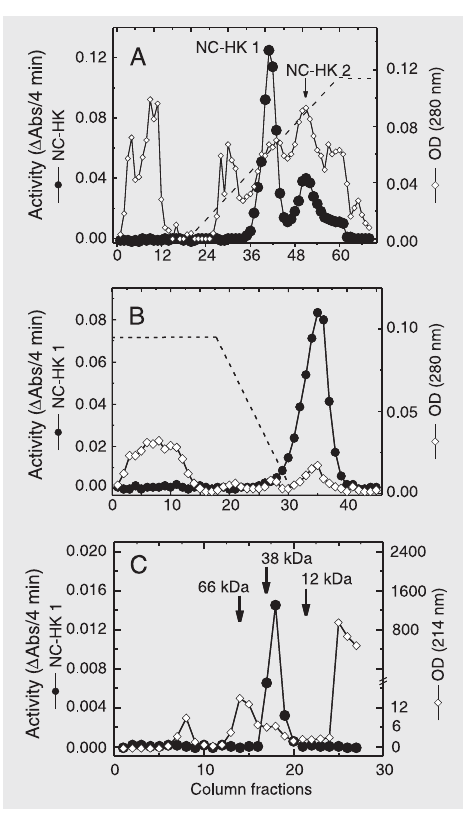
Figure 2. A , Anion exchange chromatography on a DEAE-Toyopearl column of the CHAPS-solubilized ac- tivity of NC-HK from mitochondrial maize roots. HK